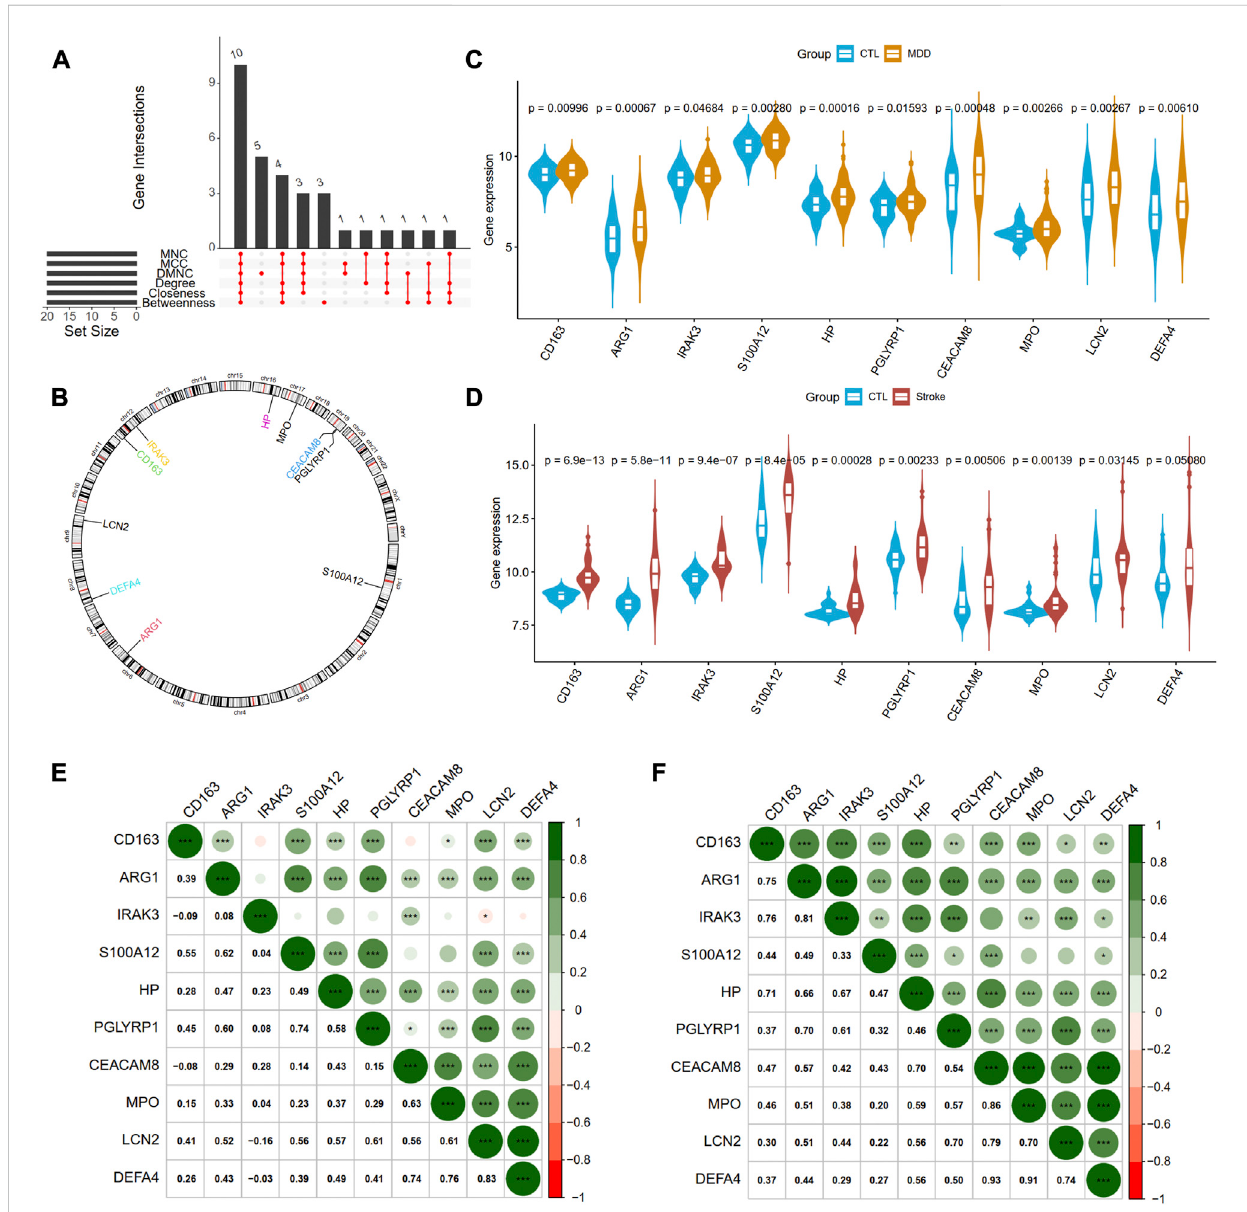
FIGURE 6 Identi fi cation of hub genes from PPI network. (A) A Venn diagram shows ten overlapped genes that were screened out by the six methods from the top 20 genes of six methods in Cytohubba plug in Cytoscape. (B) The gene locations of the ten hub genes. (C) and (D) shows the expression levels of the tenhub genesinMDD and IS,respectively. (E) and (F) depictedthecorrelationsof thetengenes with eachother inMDD and IS,respectively. Signi fi cance level was denoted by * p -value < .05, ** p -value < .01, *** p -value < .001.